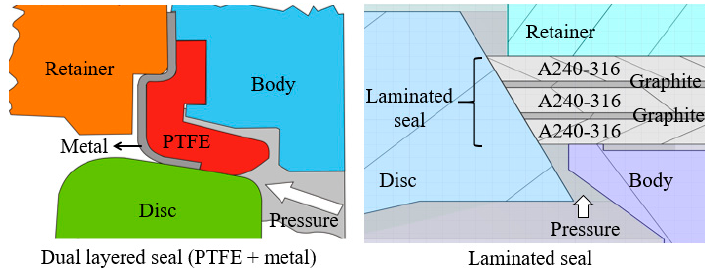
Figure 4. Existing dual seal and new laminated seal. PTFE, polytetrafluoroethylene.